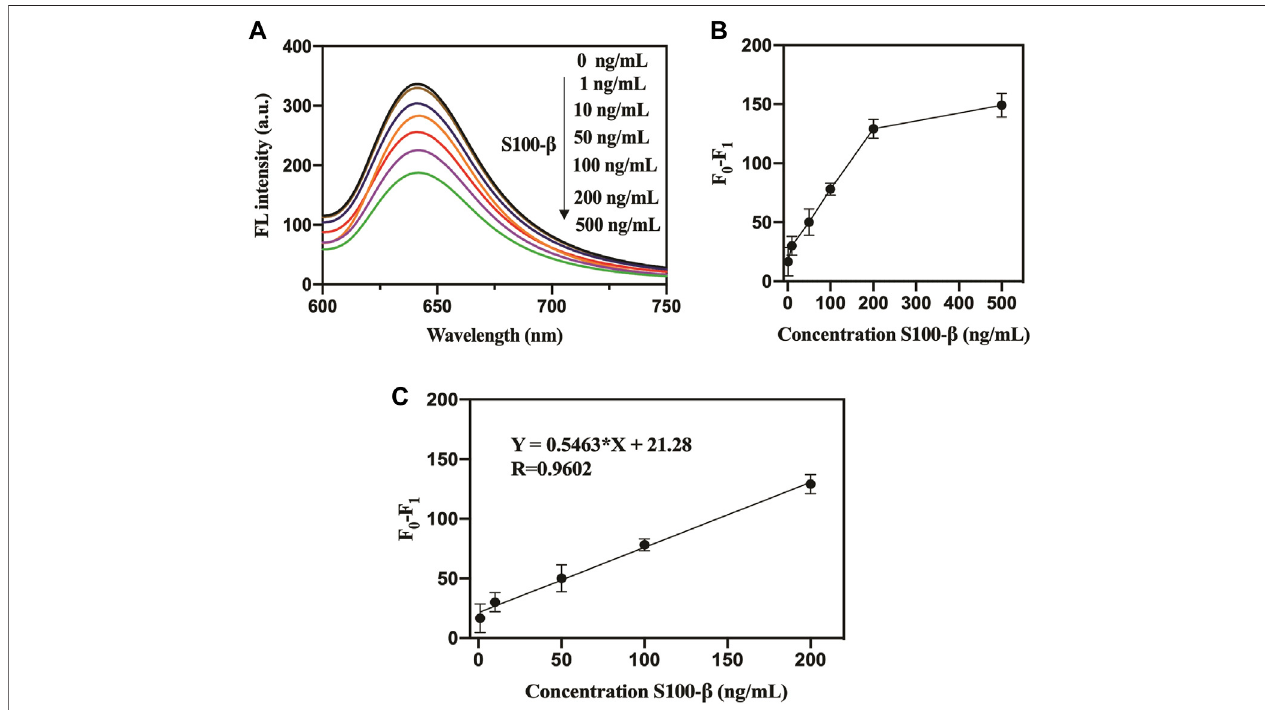
FIGURE 5 | (A) . Fluorescence response of pep-CPD nanoprobe toward S100- β in serum. (B) . The relationship between the amounts of S100- β and the relative fl uorescence intensity. (C) . Linear relationship between the relative fl uorescence intensity of pep-CPDs and different concentrations of S100- β in serum. F0 and F1 represent the fl uorescence intensity of the pep-CPDs in the addition of S100- β and without.